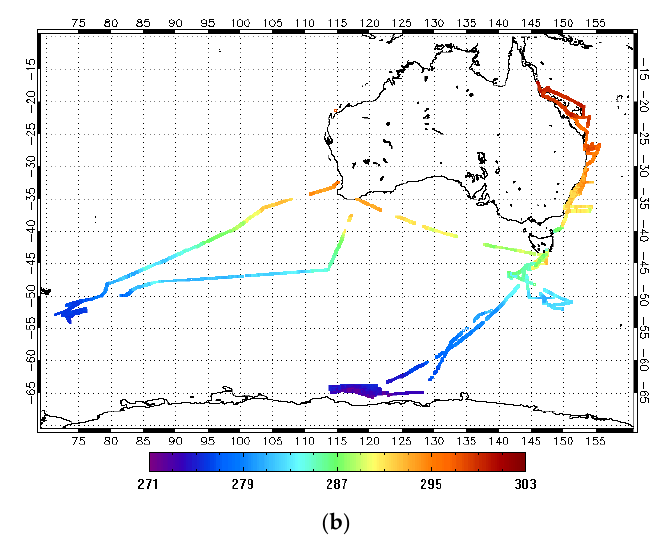
Figure 1. ( a ) The RV Investigator ISAR cruise tracks included in this study; ( b ) cruise tracks with ISAR skin SST measurements (K).